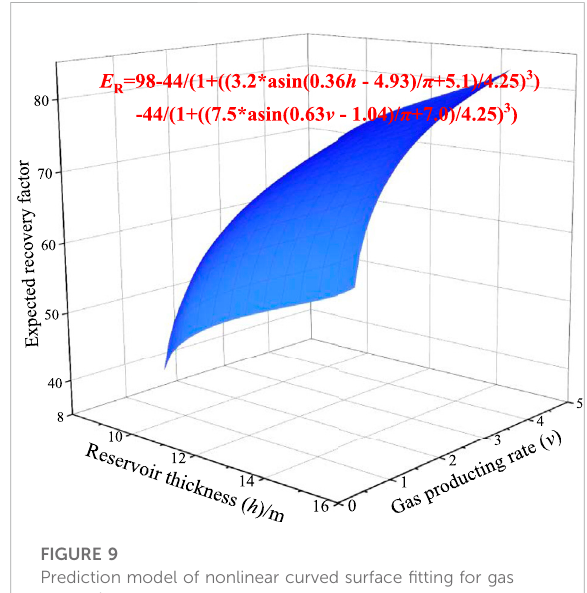
FIGURE 9 Prediction model of nonlinear curved surface fi tting for gas reservoir